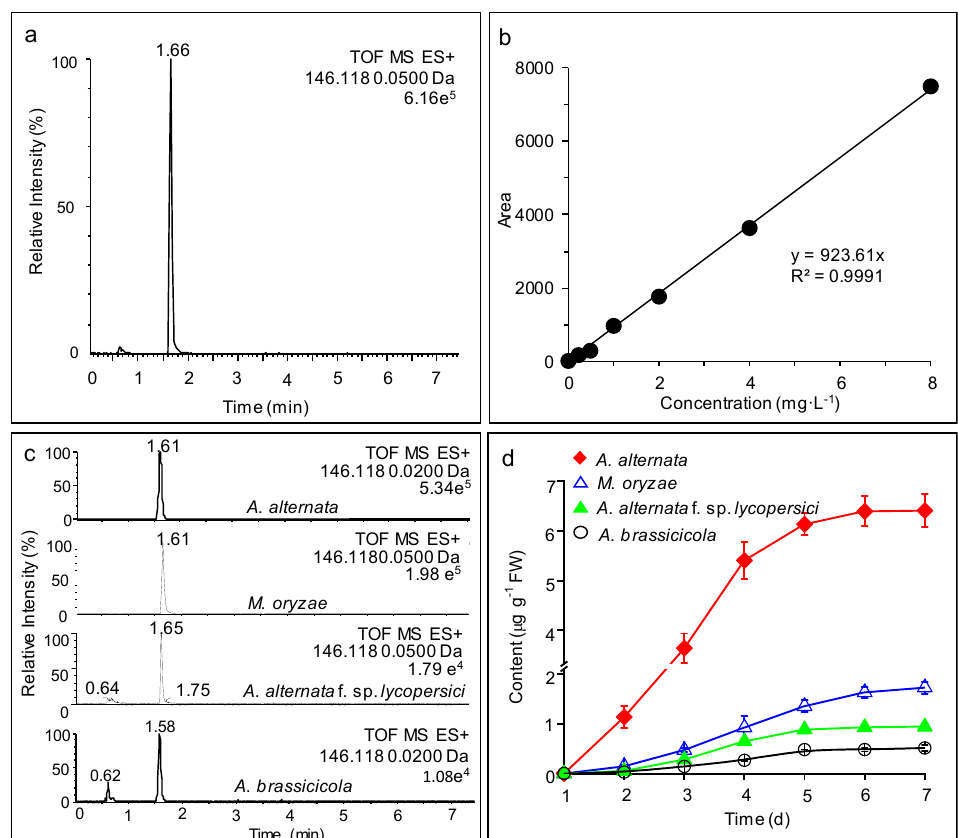
Figure 3. Quantification of AMHA produced by mycelia of four different fungi cultivated on Czapek solid medium. ( a ) UPLC ‒ MS chromatogram of standard AMHA with 8 mg L − 1 in positive ion mode. ( b ) Calibration curve of the peak signal area at 1.66 min vs. concentration of AMHA standard (mg L − 1 ). ( c ) UPLC ‒ MS chromatograms in positive ion mode of the extracts from 7-day-old mycelia of A. alternata , M. oryzae , A. alternata f. sp. lycopersici or A. brassicicola . ( d ) AMHA production by mycelia of four fungi during the first 7 d of culture on Czapek solid medium. Results represent three independent biological replicates. Data in D represent mean values ± SD.